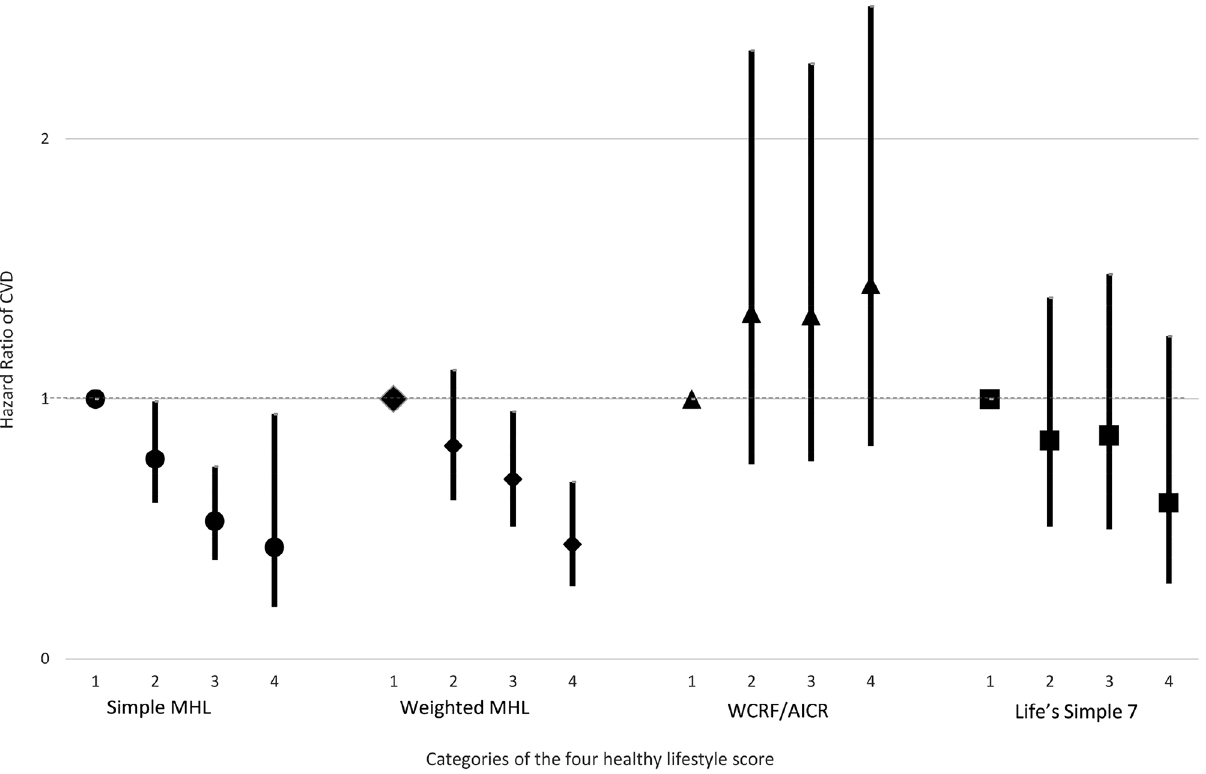
Figure 1. Hazard ratios for cardiovascular disease specified by categories according to the numbers of healthy lifestyle factors among participants stratified by simple Taiwan healthy lifestyle score, weighted Taiwan healthy lifestyle score, WCRF/AICR recommended healthy lifestyle score and Life’s Simple 7. MHL Mediterranean diet related healthy lifestyle score, WCRF/AICR World Cancer Research Fund/American Institute for Cancer Research.